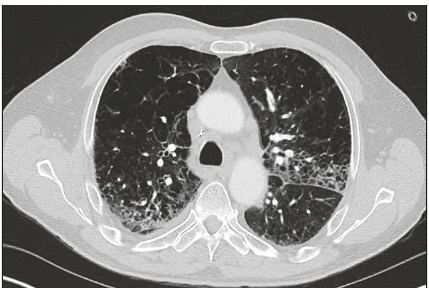
Figure 1: Chest Computed Tomography (CT) angiogram obtained to rule out pulmonary embolism (PE) showed diffuse bilateral pulmonary infiltrates, mediastinal lymphadenopathy, and small bilateral pleural effusions.